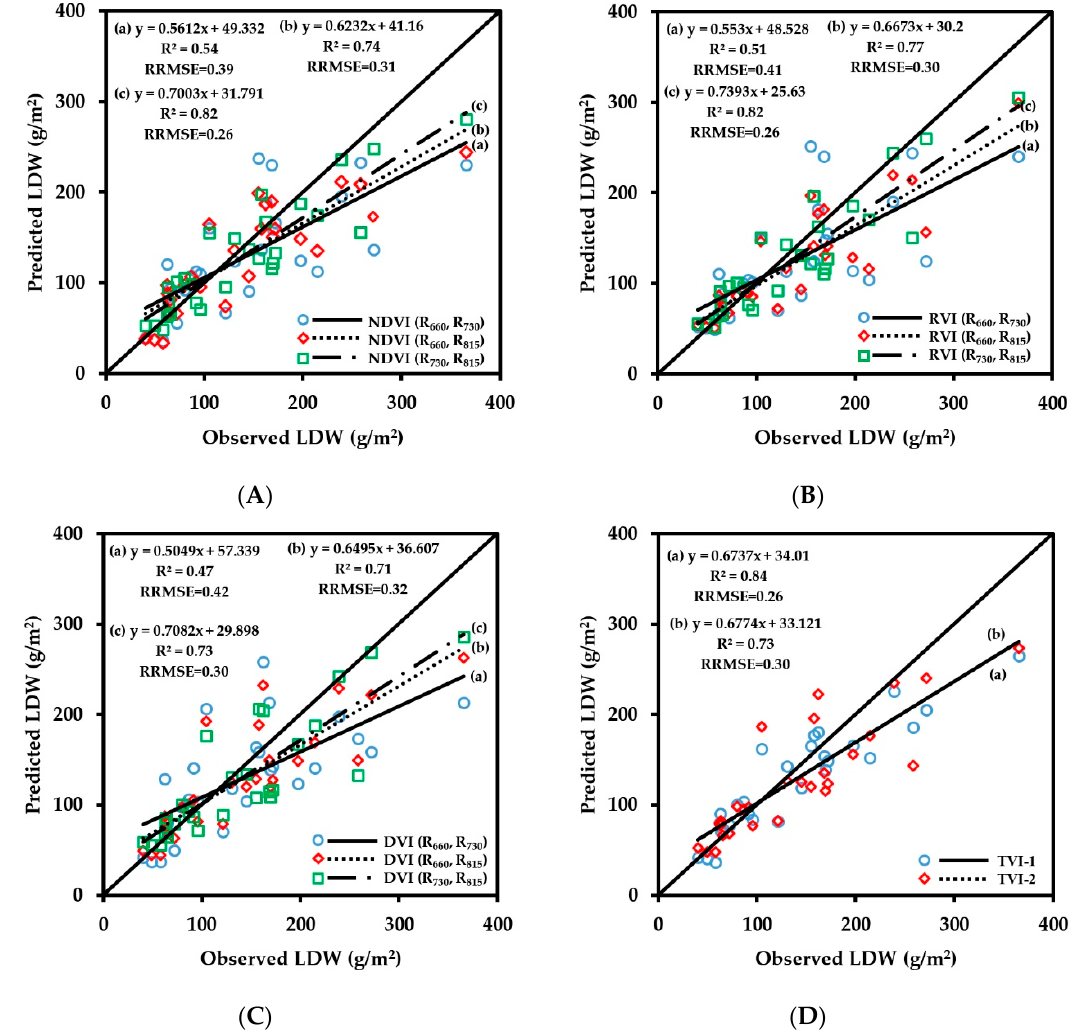
Figure 9. The relationships between observed and predicted LDW values of wheat varieties based on NDVI ( A ), RVI ( B ), DVI ( C ) and TVI ( D ) models.